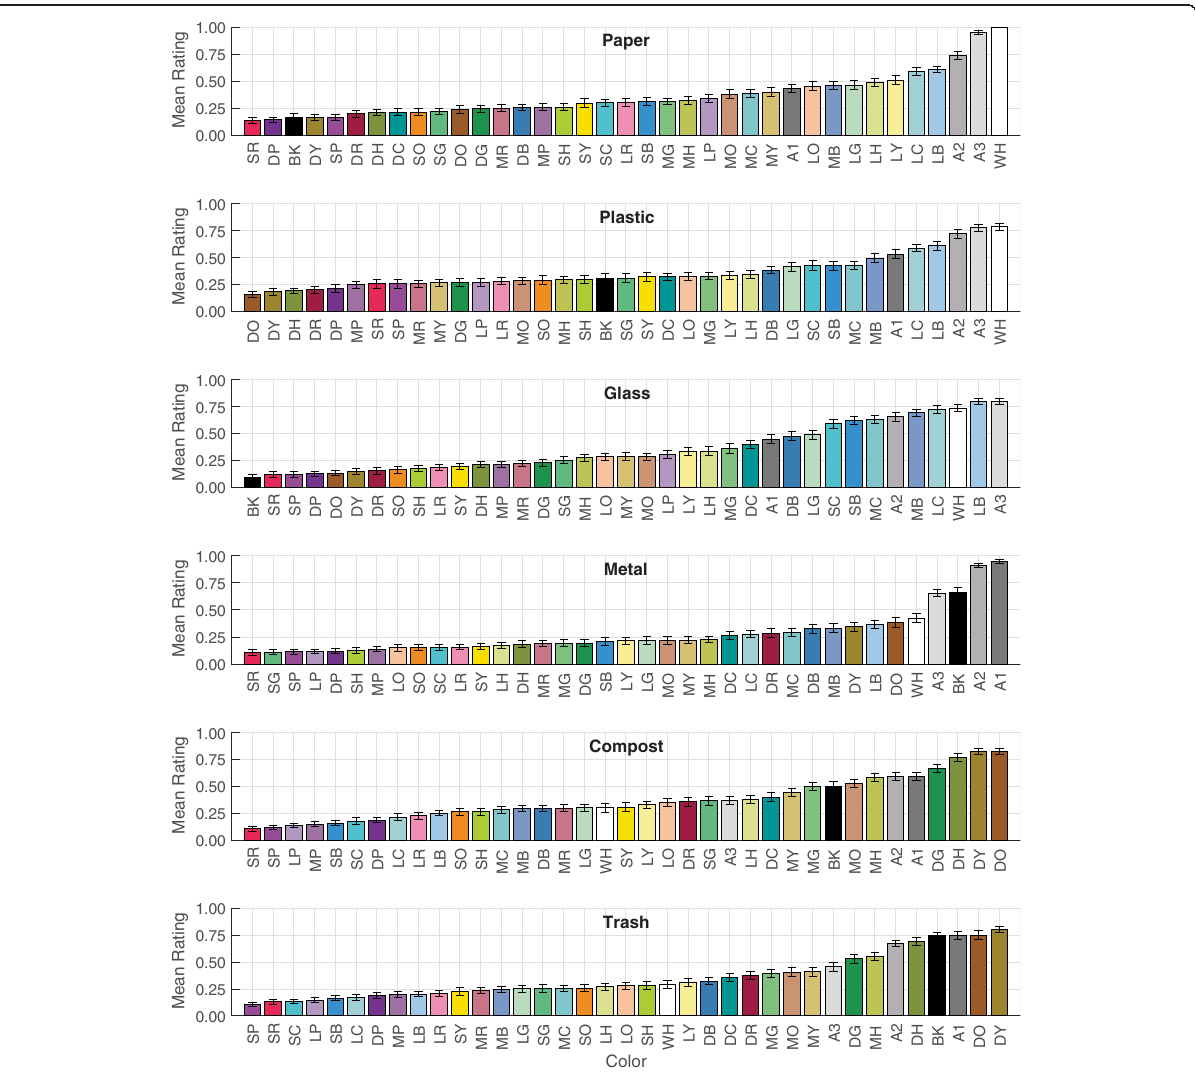
Fig. 4 Mean color-object association ratings for paper, plastic, glass, metal, compost, and trash. Colors are sorted along the x-axis from most weakly associated to most strongly associated with each object. Bar colors represent the colors that were judged (also see x-axis label and corresponding coordinates in Additional file 1: Table S1). Error bars represent the ± standard errors of the means. See Additional file 1 for details on how the data were